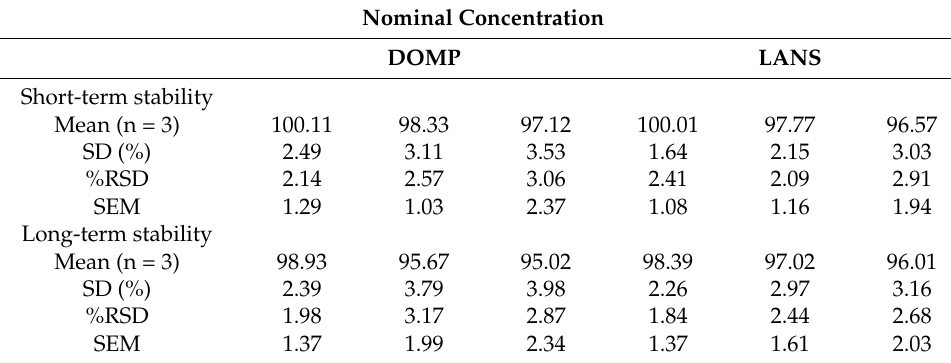
Table 4. Short-term and long-term stability of DOMP and LANS.